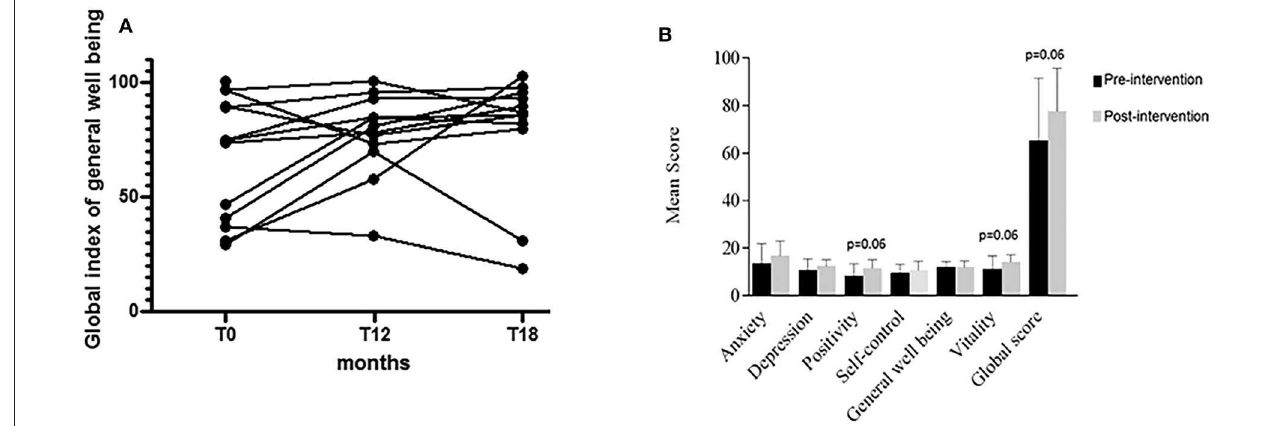
FIGURE 2 | Assessment of general psychological well-being. (A) At baseline assessment, a “severe” level of distress was found in 5 of 13 patients (38%), with scores lower than 59. At the end of intervention (T12), nine of the 12 remaining patients showed an increase in the PGWB scores compared with the baseline pattern, but in three cases, the scores were lower compared with baseline. One patient, who showed a condition of severe distress at baseline, improved at the end of the intervention but returned to his/her basal condition as early as 6 months after transition. One patient showed a slight deterioration of the well-being index during the intervention, which further worsened after transition. (B) The score increase was more pronounced in the two specific domains of vitality and positivity. The global score of general well-being increased at the end of intervention, although the value did not reach statistical significance ( p = 0.06).